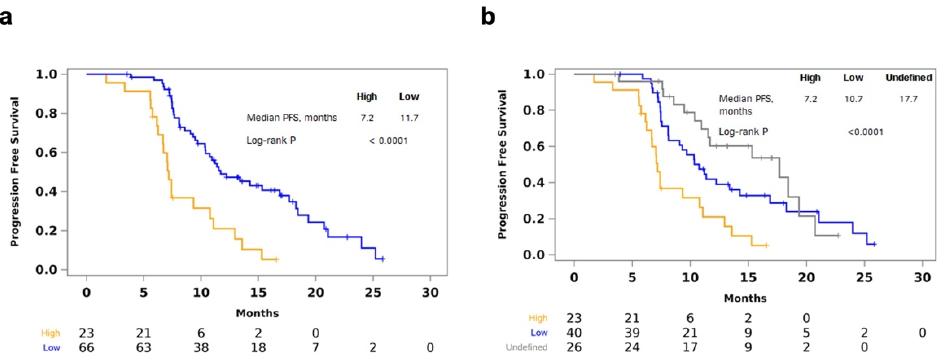
Figure 3. Shorter PFS in high post-induction MATH. ( a ) Kaplan–Meier curves showing shorter PFS with high tumor heterogeneity, defined as MATH in the top quartile in post-induction plasma; ( b ) longer PFS with MATH below the top quartile or undefined, i.e., samples with 0 or 1 somatic mutations detected.